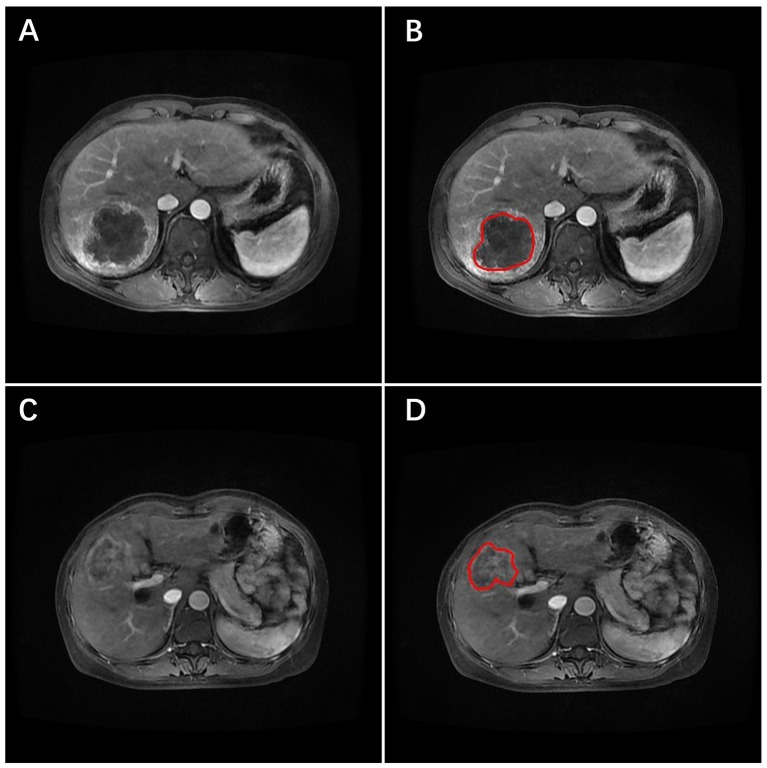
Arterial-phase contrast-enhanced MRI images of two patients with ICC. The tumor was identified, and the region of interest (ROI) placed (red line) on the images. (A,B) The primary image and the ROI (red line) marked image for one patient developed early recurrence. (C,D) The primary image and the ROI marked (red line) image for the other patient did not develop early recurrence.